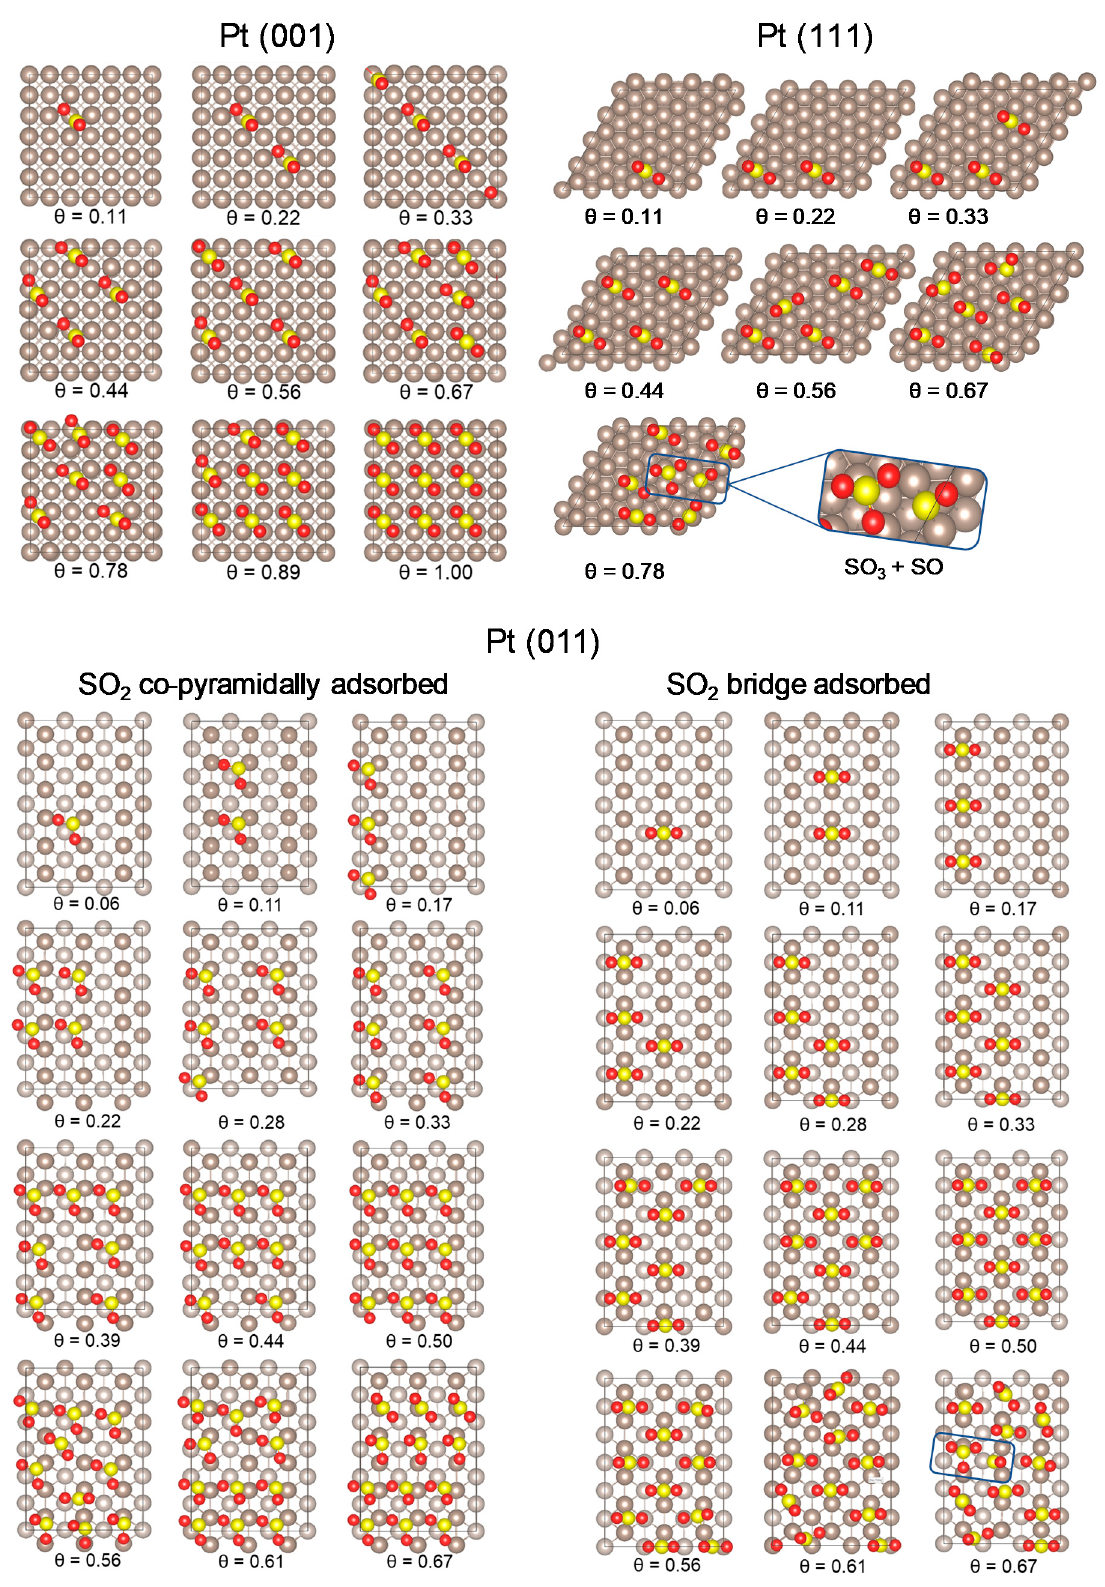
Figure 4. Increased adsorption coverage of SO 2 on the Pt (001), (011), and (111) surfaces.